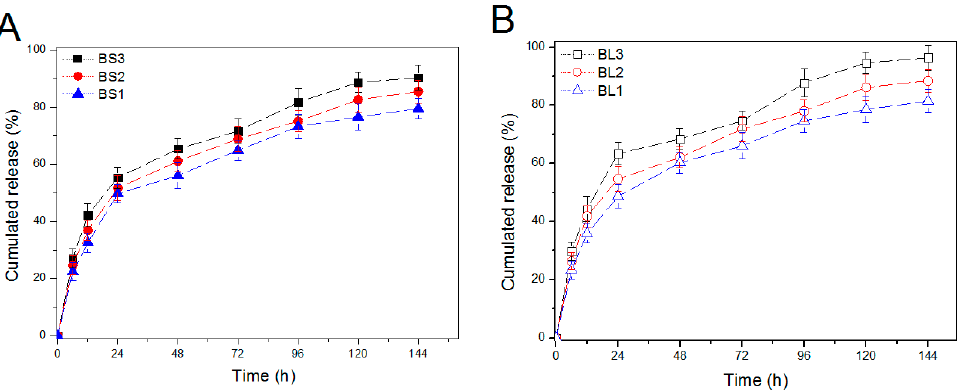
Figure 3. IGF-1 release profiles from 5 mg of BS1, BS2, and BS3 NPs (( A ), initial IGF-1 load in BS1, BS2 and BS3 was 1.93, 4.61, and 7.27 ng / mg) and BL1, BL2, and BL3 NPs (( B ), initial IGF-1 load in BL1, BL2, and BL3 was 2.29, 5.72, and 9.21 ng / mg) in 500 µ L PBS (see Table 2 for their parameters).